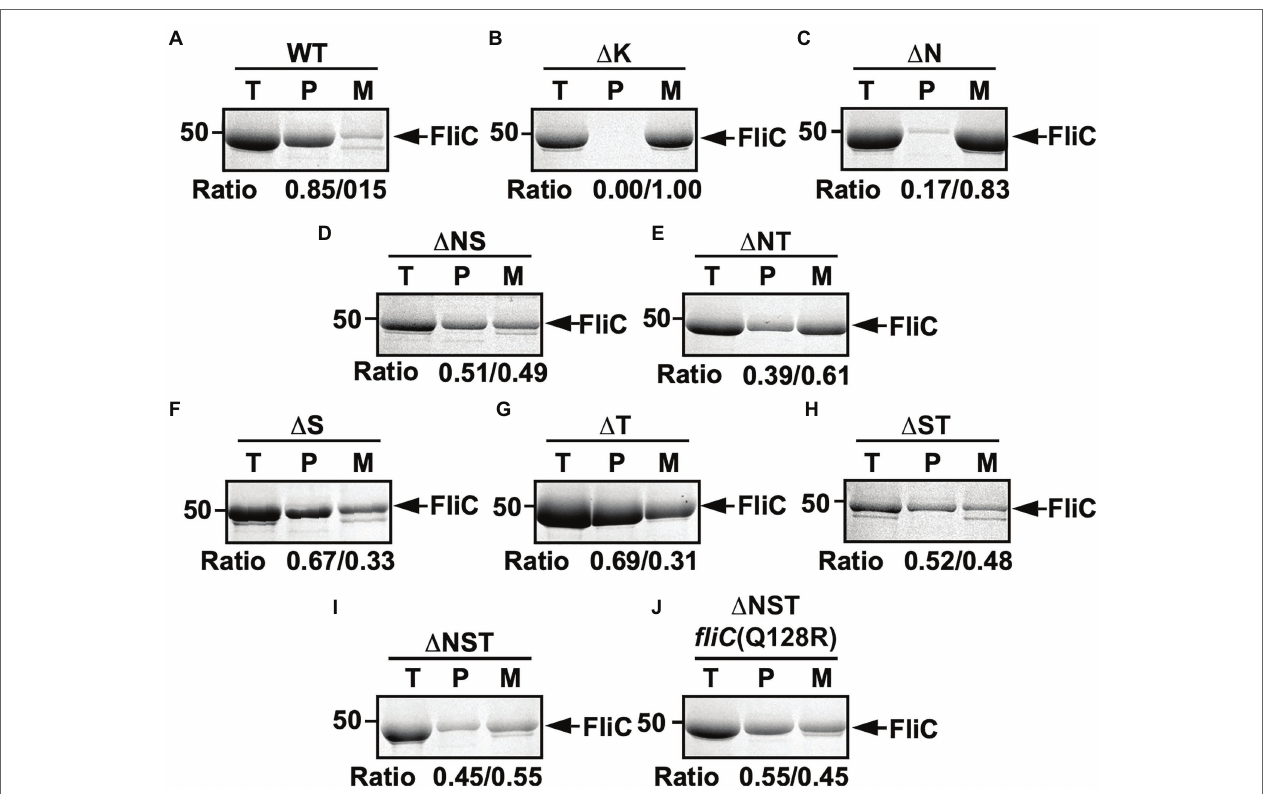
FIGURE 2 | Effect of removal of flagellar export chaperones on FliC leakage during filament assembly. Measurements of FliC monomers leaked out into the culture media. CBB-staining SDS gels of total extracellular FliC proteins (indicated as T), polymerized FliC subunits in the filament (indicated as P), and FliC monomers leaked into the culture media (indicated as M) of (A) wild-type (WT), (B) flgK ( ∆ K), (C) ∆ flgN ( ∆ N), (D) ∆ flgN ∆ fliS ( ∆ NS), (E) ∆ flgN ∆ fliT ( ∆ NT), (F) ∆ fliS ( ∆ S), (G) ∆ fliT ( ∆ T), (H) ∆ fliS ∆ fliT ( ∆ ST), (I) ∆ flgN ∆ fliS ∆ fliT ( ∆ NST), and (J) ∆ flgN ∆ fliS ∆ fliT fliC (Q128R) [ ∆ NST fliC (Q128R)]. The position of 50 kDa molecular mass marker is indicated on the left. The band densities of polymerized FliC subunits and FliC monomers leaked into the culture media were normalized by the total extracellular FliC level in each strain, and then, the relative ratio of the polymerized and secreted FliC subunits was calculated. We performed three independent